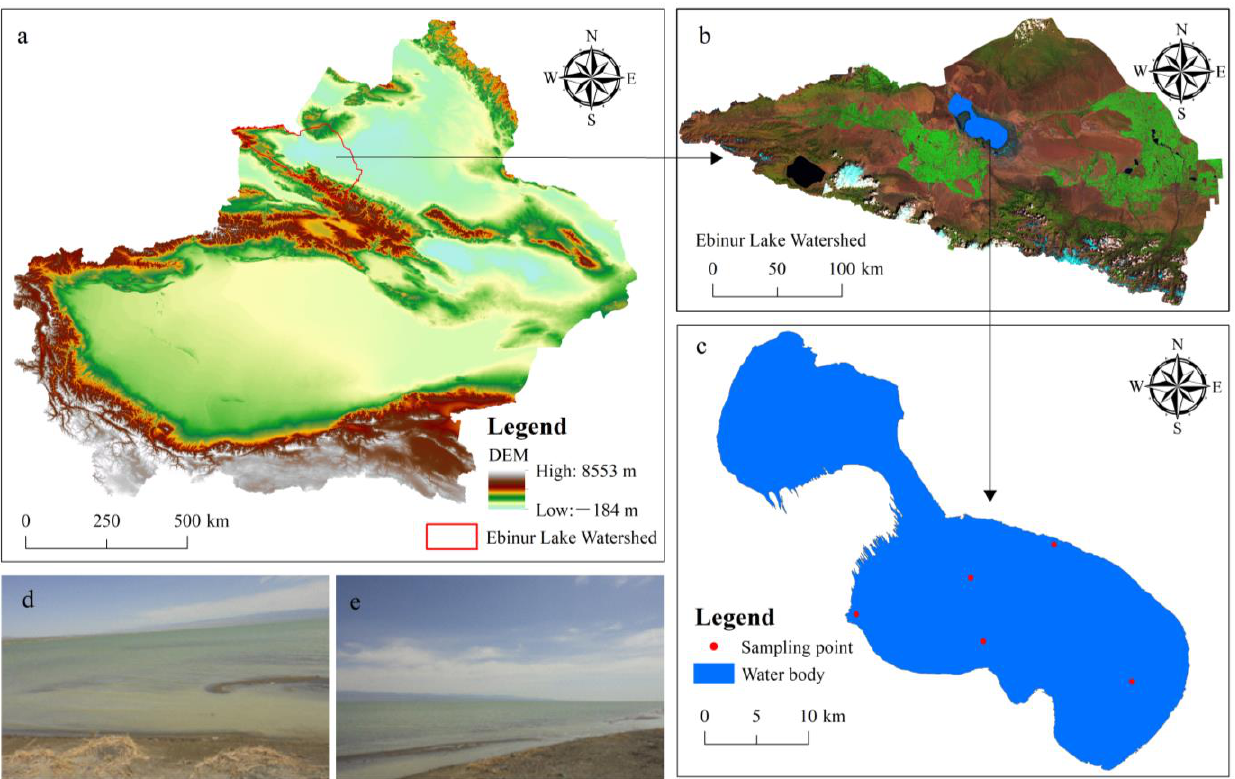
Figure 1. Location of study area: ( a ) The location and general relief of the Ebinur Lake Watershed in northwest Xinjiang, China; ( b ) The location of Ebinur Lake at the center of the Ebinur Lake Watershed; ( c ) Ebinur Lake with the locations of five sampling points; and ( d , e ) Ground photographs of Ebinur Lake and its arid landscape environs taken in May 2017.